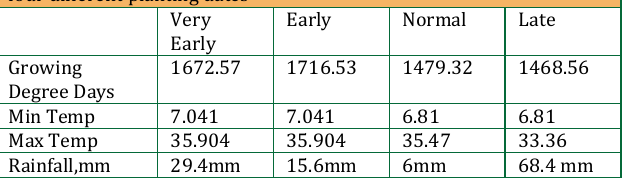
Table 1: Growing Degree Days (GDD), Temperature and Rainfall for four different planting dates